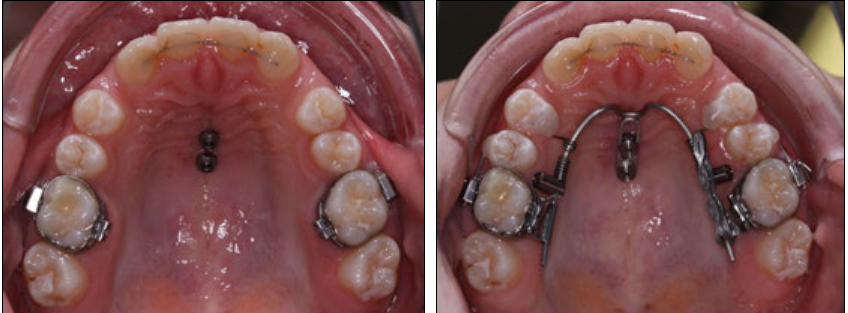
Figure 7. Occlusal view of the Mesialslider attached to two mini-implants at the start of maxillary premolar and molar